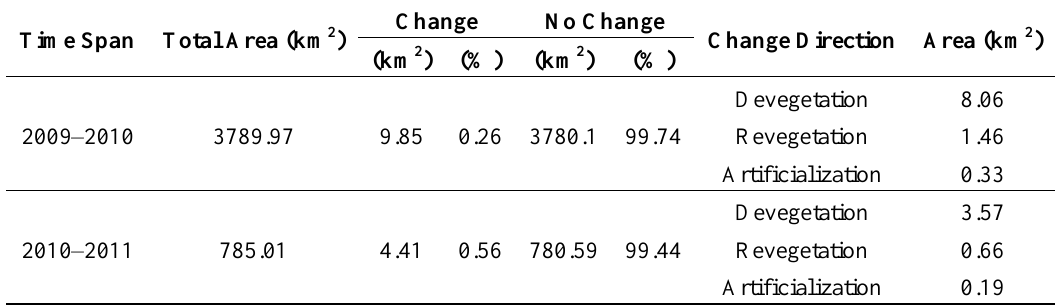
Table 4. The results of the application of the change detection algorithm to image pairs acquired in 2009–2010 and